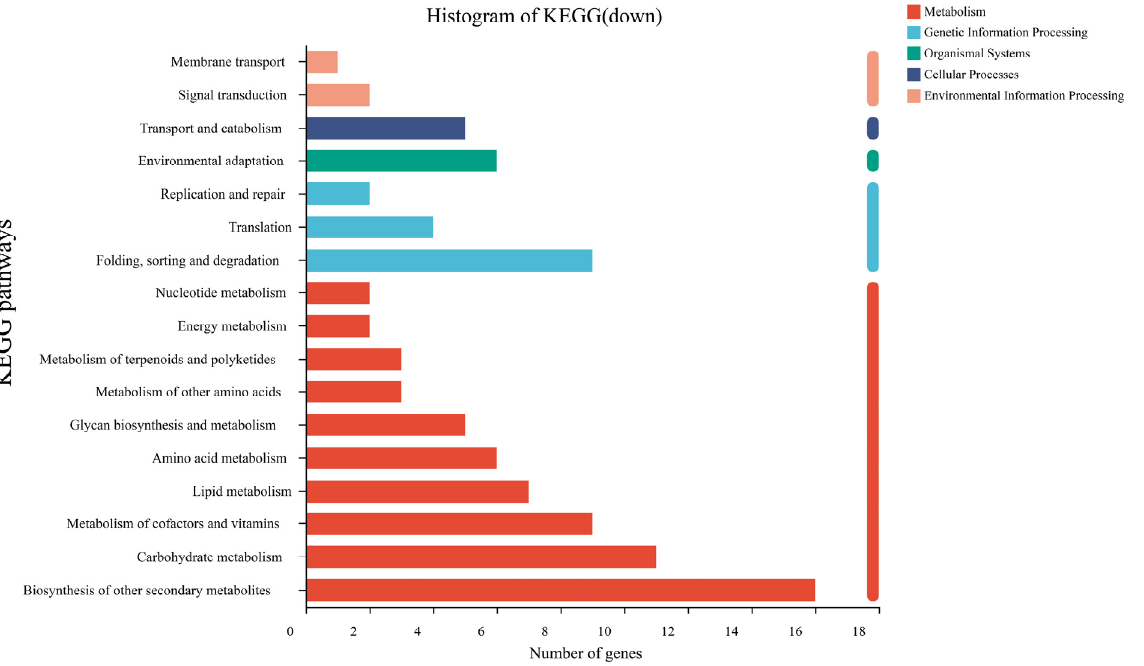
Figure 9. Key function annotation of downregulated KEGG pathway genes between the G20 (non- inoculation) and G20S (strain SR-9 inoculation) treatments.